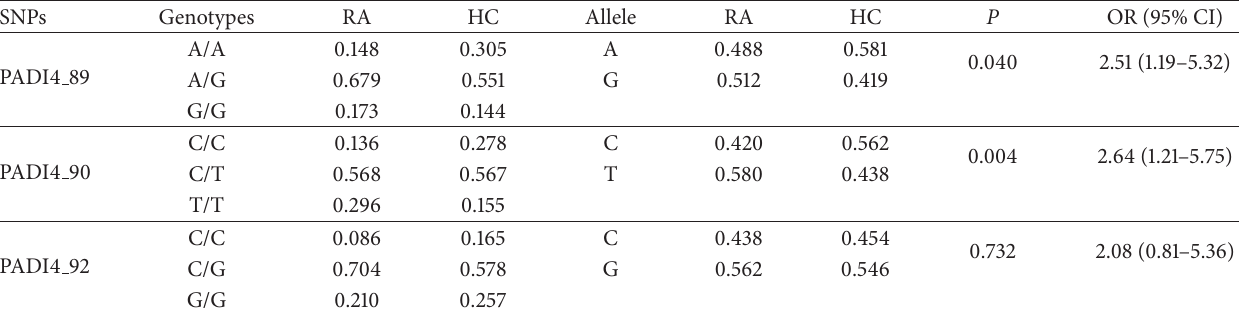
Table 3: Genotypic and allelic frequencies of PADI4 89, PADI4 90, and PADI4 92 SNPs of PADI4 gene in controls (HC 𝑛 = 98 ) and rheumatoid arthritis (RA 𝑛 = 86 ) patients.